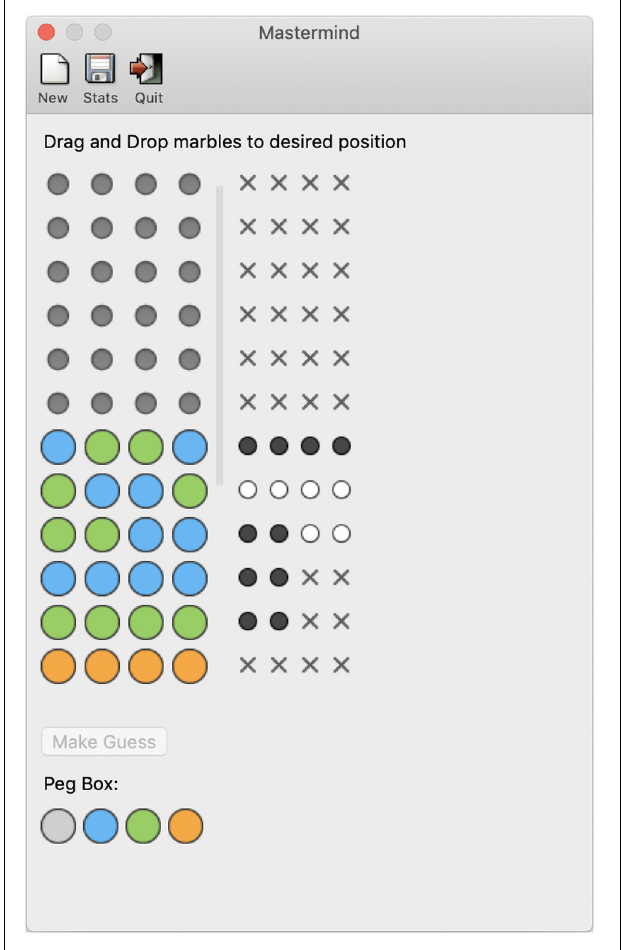
FIGURE 1 | Example of the app version of the Entropy Mastermind game. Participants make guesses by dragging the colors into the gray circles in the order they choose and then click the make guess button. This generates the feedback displayed on the right-hand side in the form of either a black circle, white circle or cross. A cross means that the item in the code is wrong in both position and color, a white circle means that the item is correct in color but not position and a black circle means that the item is correct in both position and color. The position of the feedback does not correspond with the position of the items in the guess. The first three lines of this example demonstrates that there are no orange colors in the code but there are two green and two blue. Guess number four shows that only two of the colors are in the right place and guess number five shows that none of the items are placed correctly. This information was used to decipher the correct position of the colors as shown in guess